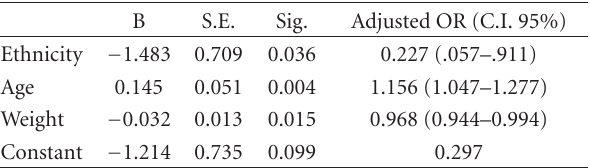
Table 4: Adjusted odds ratio (OR) for anemia in children with DS.